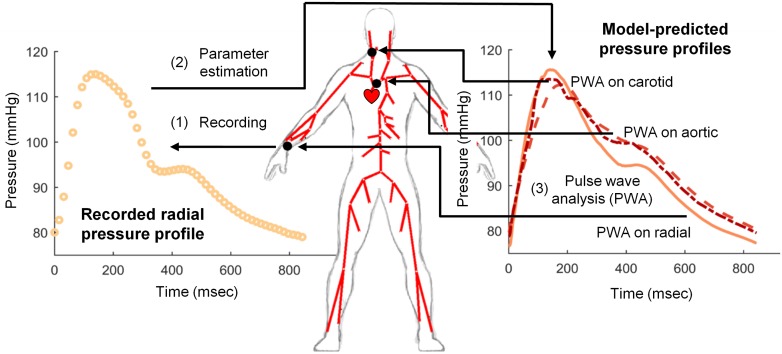
Schematic representation of the study workflow.(1) Radial pressure waveforms were recorded in 20 healthy subjects using applanation tonometer. (2) Recorded pressure waveforms were used to estimate parameters of the blood flow model in the system of 55 compliant arteries. (3) Pulse wave analysis using SphygmoCor software was performed on model-predicted radial, carotid, and aortic pressure waveforms separately.